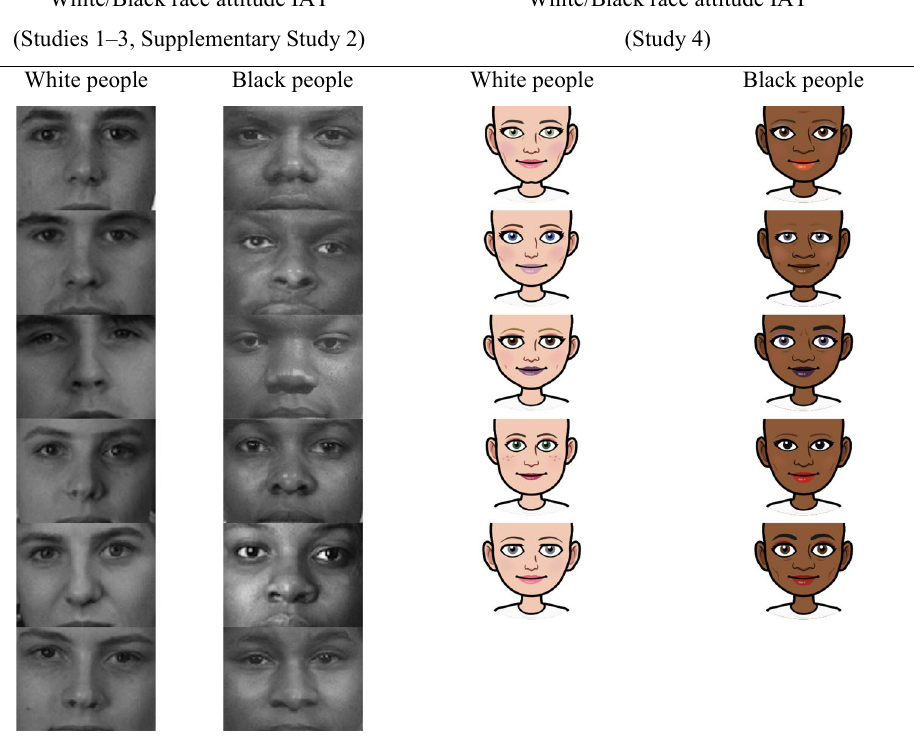
Table 2 Category stimuli used on the White/Black race attitude IATs in Studies 1–3 and Supplementary Study 2, and Study 4.